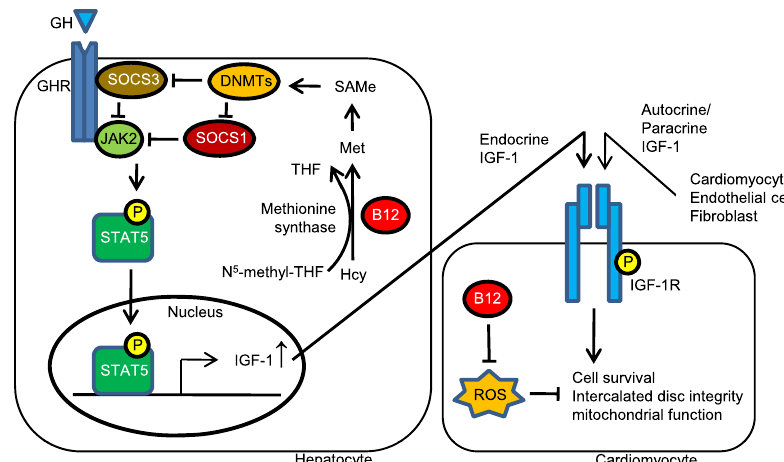
Fig. 8 A proposed mechanism whereby cobalamin (B12) prevents diabetic cardiomyopathy. B12 as an essential cofactor of methionine synthase increases hepatic levels of SAMe. SAMe is not only the methyl donor for DNMTs to methylate the promoters of SOCS1 and SOCS3, but also increases the expression of DNMTs, which further enhances the SOCS1/3 methylation. Both SOCS1 and SOCS3 suppress the activity of JAK2, which is the protein responsible for phosphorylating STAT5. The phosphorylated STAT5 translocates into the nucleus and stimulates the transcription of IGF-1 in hepatocytes. Circulating as well as locally produced IGF-1 binds to the cardiac IGF-1 receptor, which is phosphorylated to stimulate the cardioprotective IGF-1 signaling that increases cell survival and ameliorates diastolic and systolic functions in the diabetic heart. Additionally, B12 contributes to the cardioprotection by directly reducing ROS in diabetic cardiomyocytes and producing IGF-1 locally. Met, methionine; Hcy, homocysteine; THF,